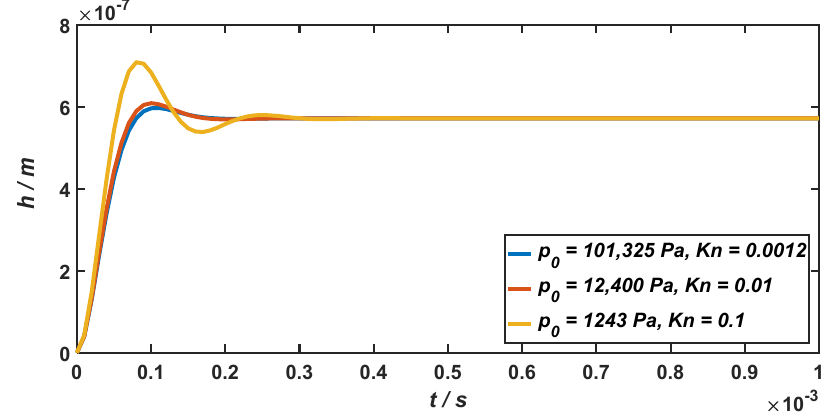
Figure 9. The step responses of the micro-accelerometer when the air pressure drops from the standard atmospheric pressure to 1243 Pa.